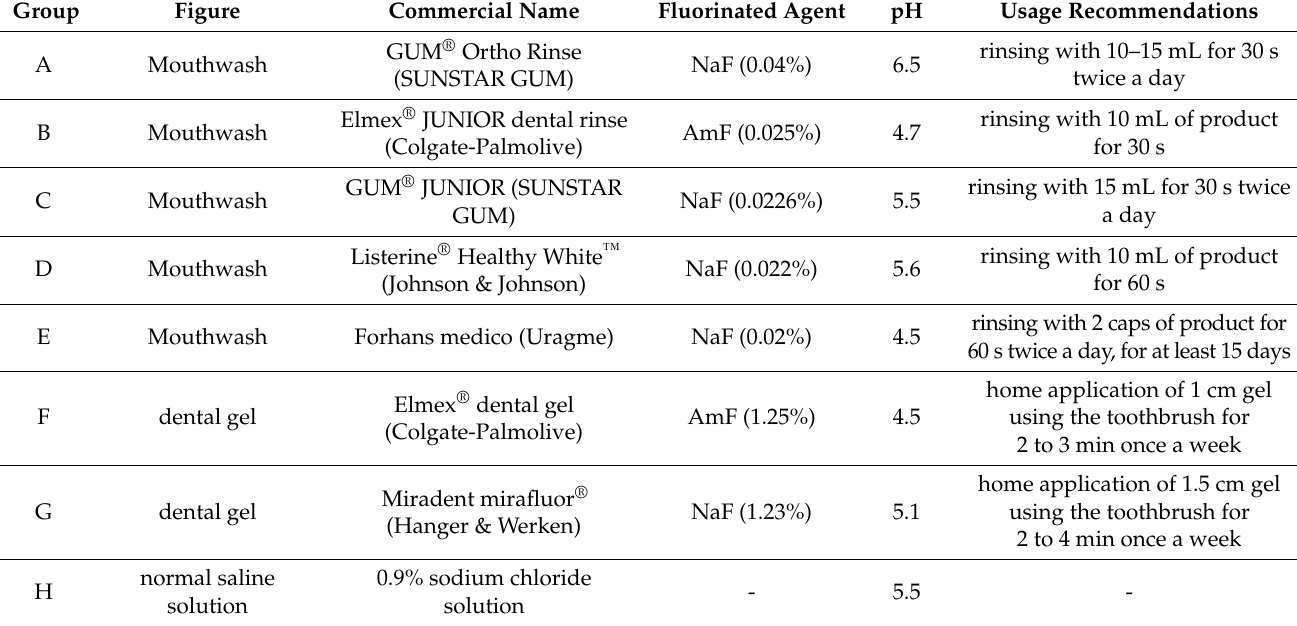
Table 1. Fluoride mouthwashes, gels, and normal saline solution taken in exam in the in vitro study. Group Figure Commercial Name Fluorinated Agent pH Usage